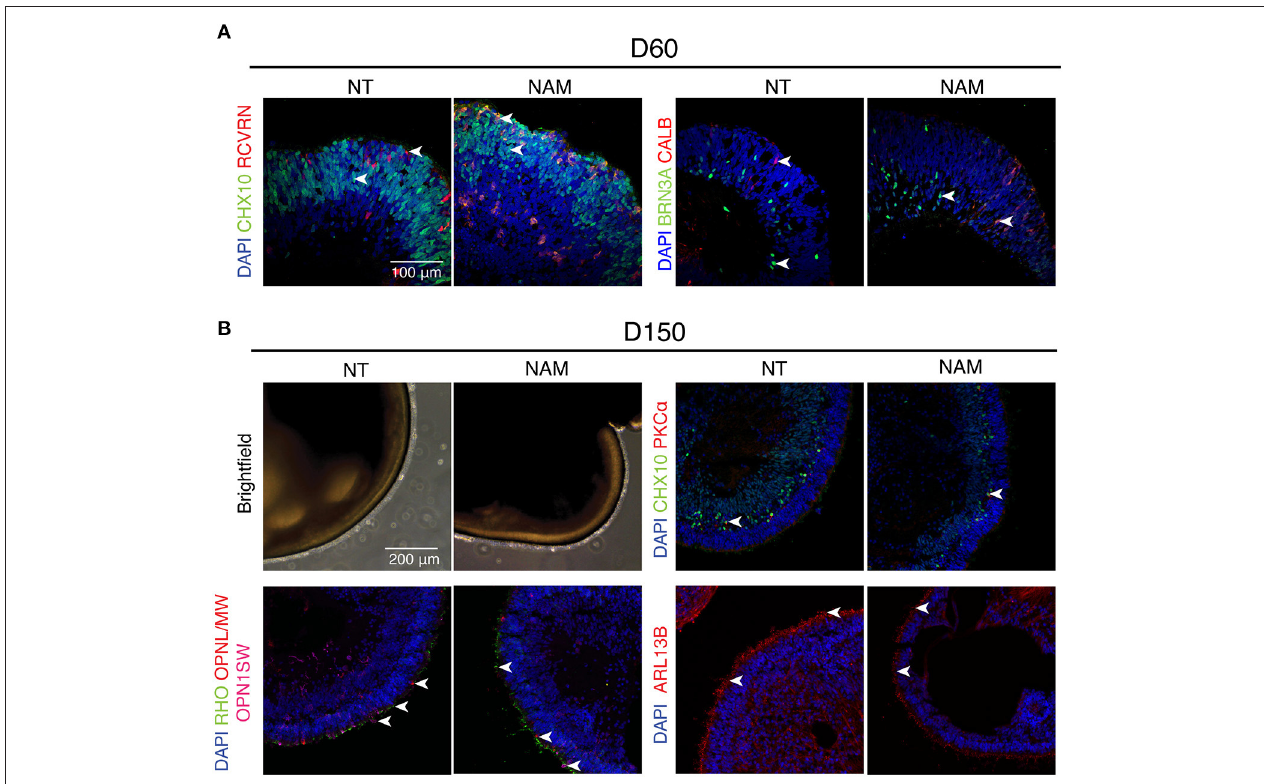
FIGURE 2 | Non-treated (NT) and Nicotinamide (NAM)-treated retinal organoids displayed similar biogenesis of major retinal cell types at differentiation day 60 and 150. (A) Immunohistochemistry analysis of human induced pluripotent stem cell (hiPSC)1-derived ROs at D60 using antibodies against markers for retinal progenitor or bipolar cells (CHX10, green), photoreceptor progenitor cells (RCVRN, red), retinal ganglion cells (BRN3A, green) and horizonal or amacrine cells (CALB, red). (B) Immunohistochemistry analysis of hiPSC1-derived ROs at D150 using antibodies against markers for rod bipolar cells (PKC α , red), retinal progenitor or bipolar cells (CHX10, green), cone photoreceptors (OPN1SW, magenta; OPNL/MW, red), rod photoreceptors (RHO, green) and cilia (ARL13B, red). Nuclei were stained with 4 ′ ,6-diamidino-2-phenylindole (DAPI, blue). Arrowheads indicate relevant staining of each